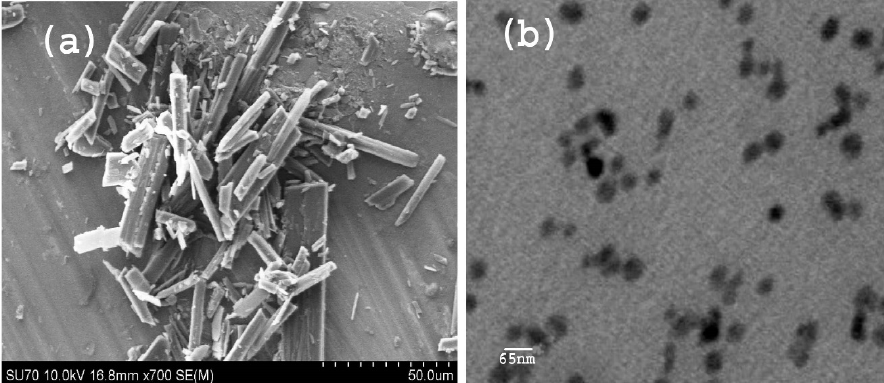
Figure 1. Images of Rp ( a ) and ( b ) at different magnification.